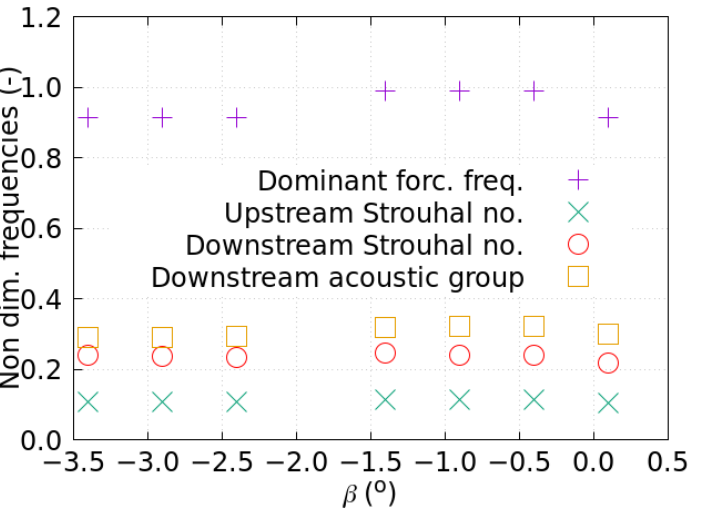
Figure 8. Parametric sweep of β , comparing dominant forcing frequency, acoustic frequency and St at different